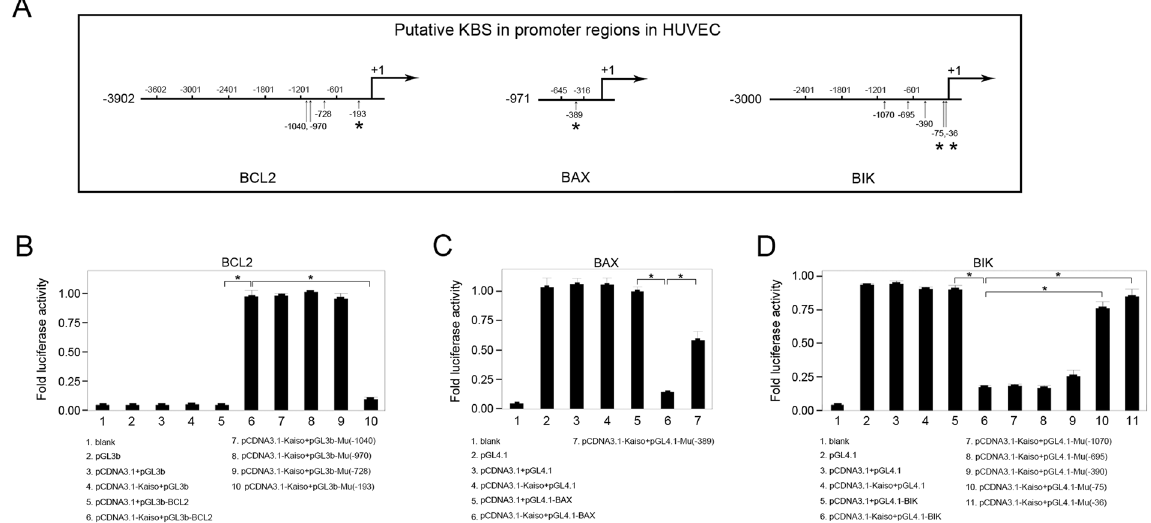
Figure 7. KBSs take part in the Kaiso mediated transcriptional regulation of BCL2, BAX and BIK. HUVECs were transfected with recombinant firefly luciferase reporter constructs pGL3b-BCL2 ( B ), pGL4.1-BAX ( C ) or pGL4.1-BIK ( D ) together with pCDNA3.1 or pCDNA3.1-Kaiso. The KBS-mutated constructs were negative controls. Renilla luciferase reporter pRL-TK was an internal control. The untreated cells served as a blank. Relative luciferase activity is presented as mean ± SD. * p < 0.01, n = 3. Positions of putative KBSs (vertical arrows) are shown in A . Asterisks in A mark the KBS mutations that mediated reversion of Kaiso regulatory effects. ( B – D ) Mutations of KBS ( − 193) in BCL2 promoter, KBS ( − 389) in BAX promoter and KBS ( − 75, − 36) in BIK promoter (asterisks in A ) significantly reversed Kaiso mediated transcriptional regulation. Site mutations in putative KBSs were listed in Supplementary Table